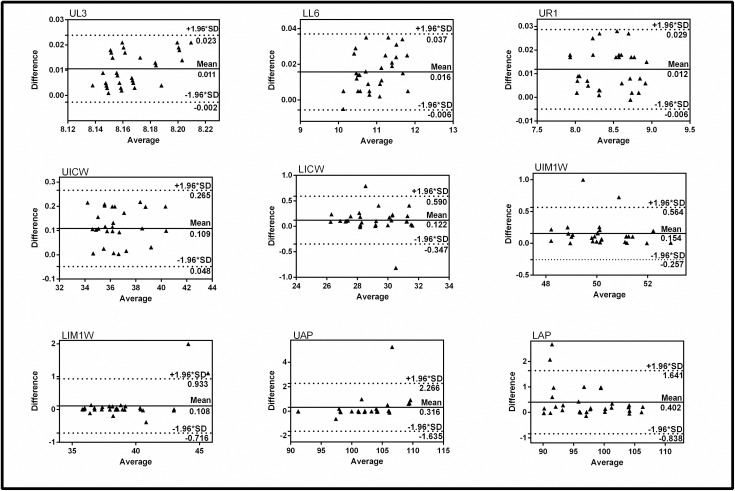
Bland-Altman plots comparing the measurements obtained by caliper-based and photogrammetric 3D digital measurement.